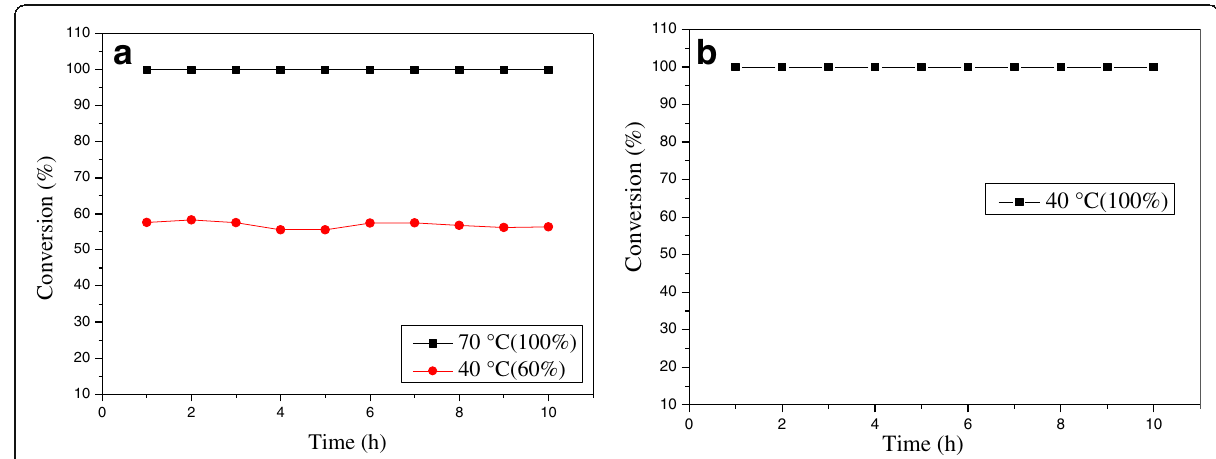
Fig. 12 The stability of 0.3% Au/Ce 0.75 -La 0.25 nanorods, reaction temperature: 40 and 70 °C ( a ) and 0.5% Au/Ce 0.75 -La 0.25 nanorods, reaction temperature: 40 °C ( b ) for the CO